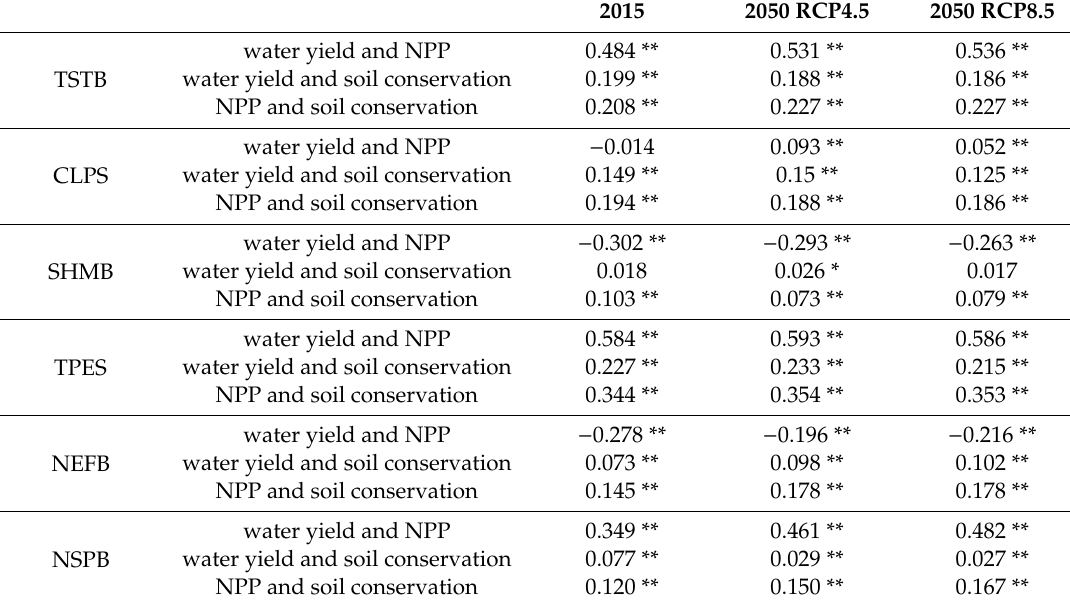
Table 3. The correlation coe ffi cients among water yield, NPP, and soil conservation in 2010 and under the two RCP scenarios in